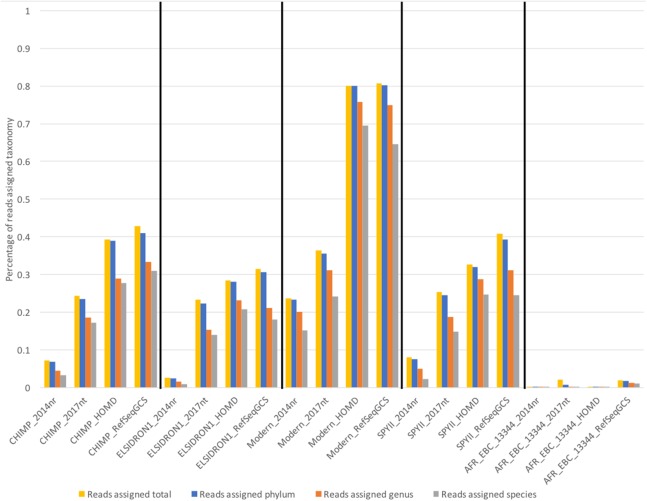
Percentage of reads assigned taxonomy to different taxonomic ranks for deeply sequenced published data.Clustered columns represent samples analysed using different reference databases. Colours indicate specificity of assignments.